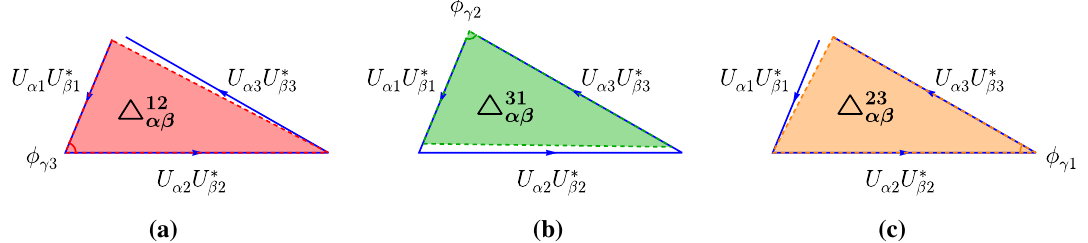
U ∗ β U ∗ β and U α (for i j i j